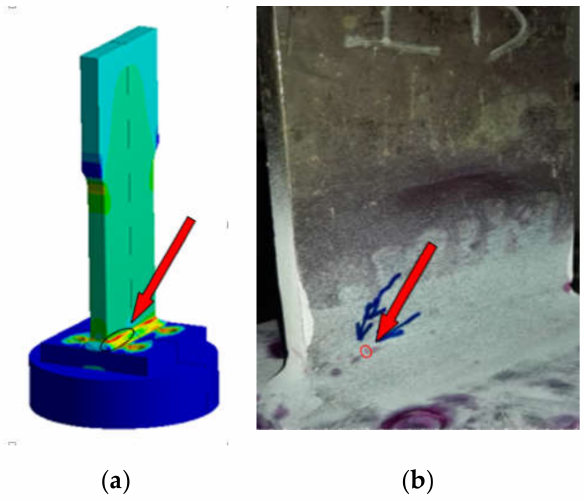
Figure 15. Comparison of fatigue damage in T-type plate joint ( a ) Finite element result ( b ) Test result.